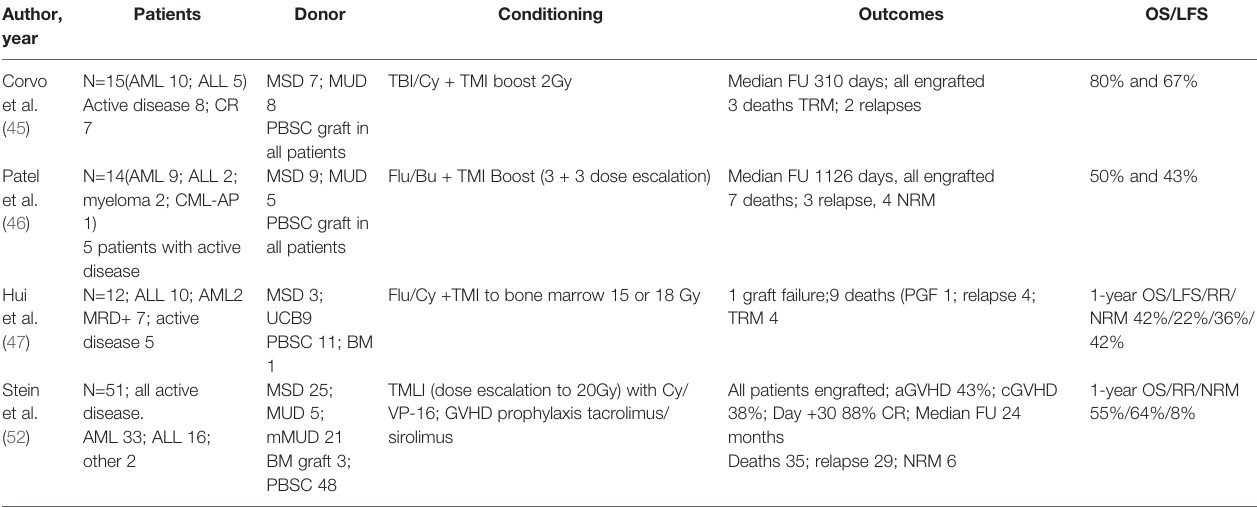
TABLE 1 | Summary of clinical trials with TMI in allo-HCT.